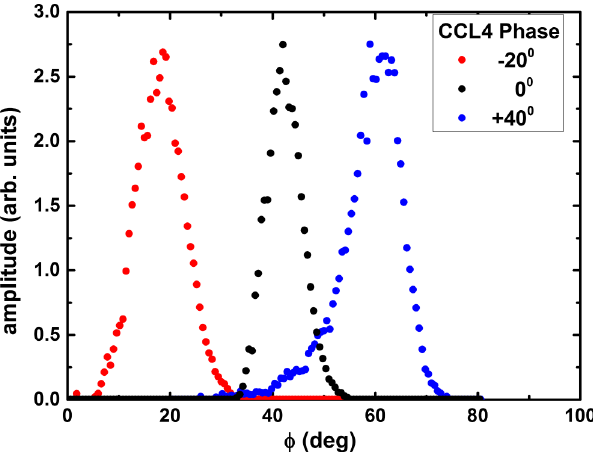
FIG. 6. The longitudinal distributions of the bunch at the CCL BSM410 measured for different phases of the CCL4 cavity. The profiles are scaled in amplitude and shifted in phase for better